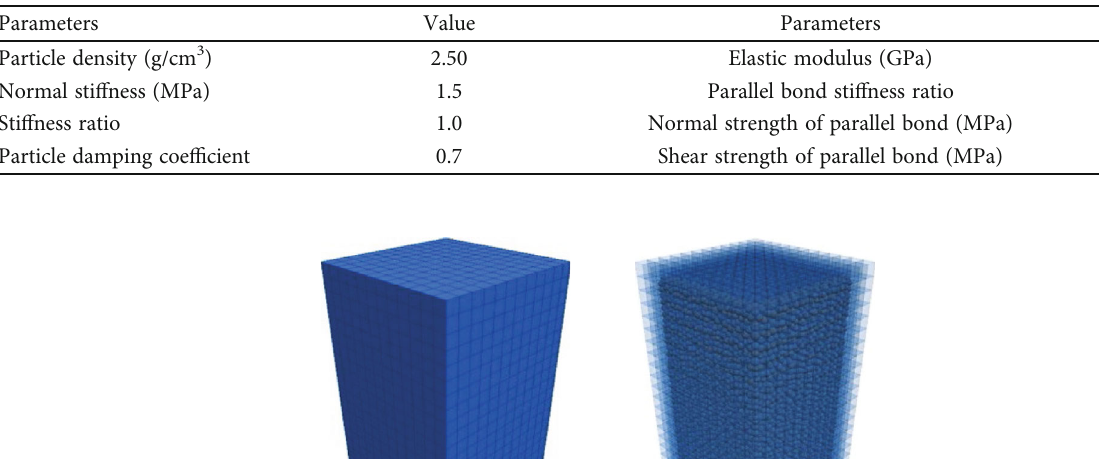
Table 2: Mesoscopic parameters of coal measures sandstone.